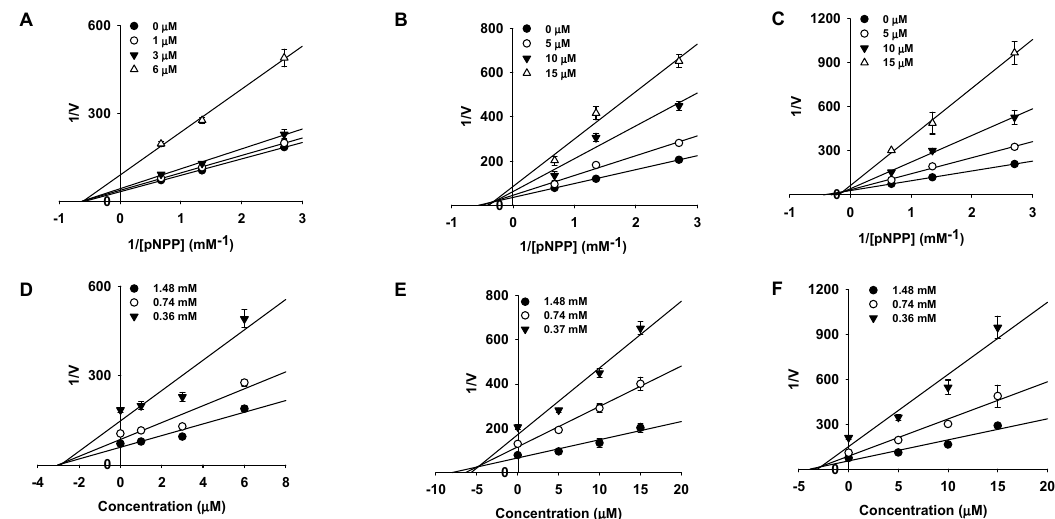
Figure 2. Lineweaver-Burk and Dixon plots for PTP1B inhibition of mulberrofuran D2 (MD2) ( A and D ), mulberrofuran D (MD) ( B and E ), and morusalfuran B (MB) ( C and F ), respectively.